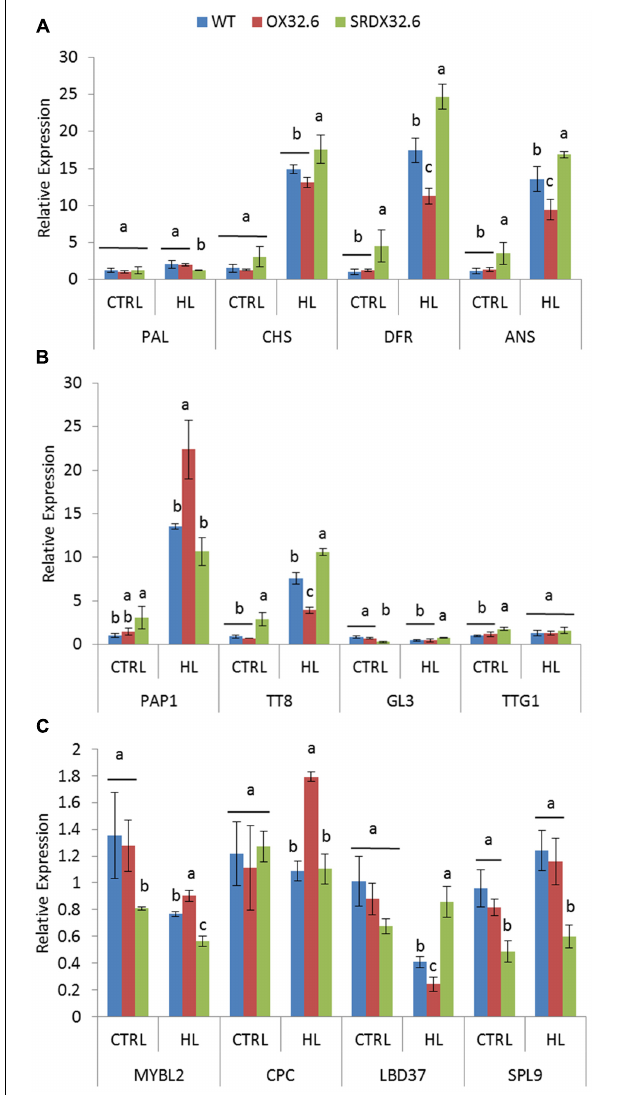
FIGURE 4 | Expression analysis of anthocyanin biosynthesis and regulatory genes in response to high light stress. (A) qRT-PCR analysis of anthocyanin biosynthesis genes (ABGs). (B) qRT-PCR analysis of positive regulators (transcriptional activators) of anthocyanin biosynthesis. (C) qRT-PCR analysis of negative regulators (transcriptional repressors) of anthocyanin biosynthesis. Seventeen-day-old WT and ANAC032 transgenic lines were treated with optimal/control (150 µ mol m − 2 s − 1 ) and high light ( ∼ 450 µ mol m − 2 s − 1 ) for 4 days. Data represent mean relative expression values ( ± SD). ACT7 was used as internal reference gene. Within each treatment, bars with different letters are not statistically similar to each other according one way ANOVA LSD test ( P <